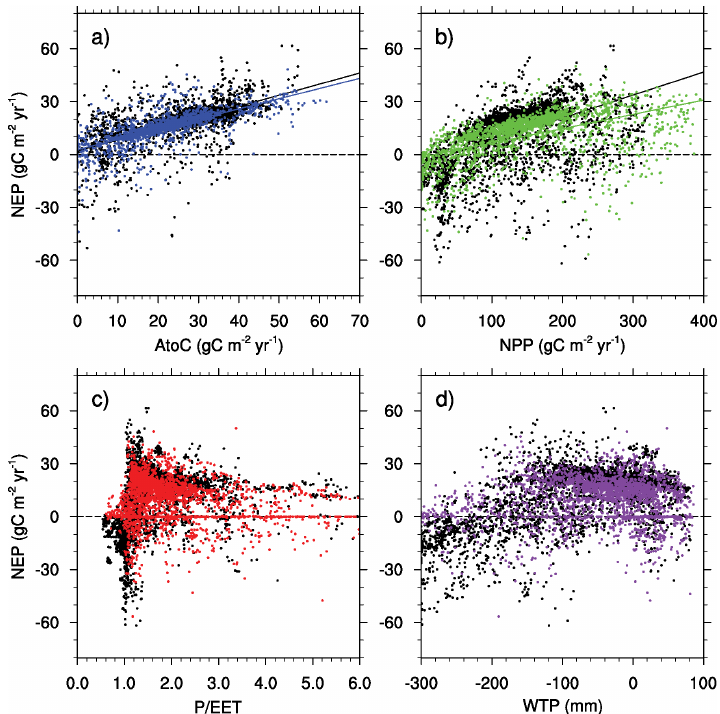
Fig. A2. Characteristics of simulated peatland NEP as a function of (a) acrotelm-to-catotelm transfer (AtoC), (b) NPP, (c) ratio of precipitation to equilibrium evapotranspiration (P/EET), and (d) water table position (WTP). Colored points are values for the period 1950–2000AD, and black dots from the 50yr period centered at 10kyrBP. The strong correlation of NEP (peat C accumulation) with NPP indicates that C accumulation is driven by plant production as suggested by Charman et al. (2013). That study also highlights that peatland ecosystems have a precipitation to equilibrium evapotranspiration ratio larger than one as shown in (c) . According to LPX simulations, NEP seems to have a relative maximum at a water table of ∼ 10cm below peat